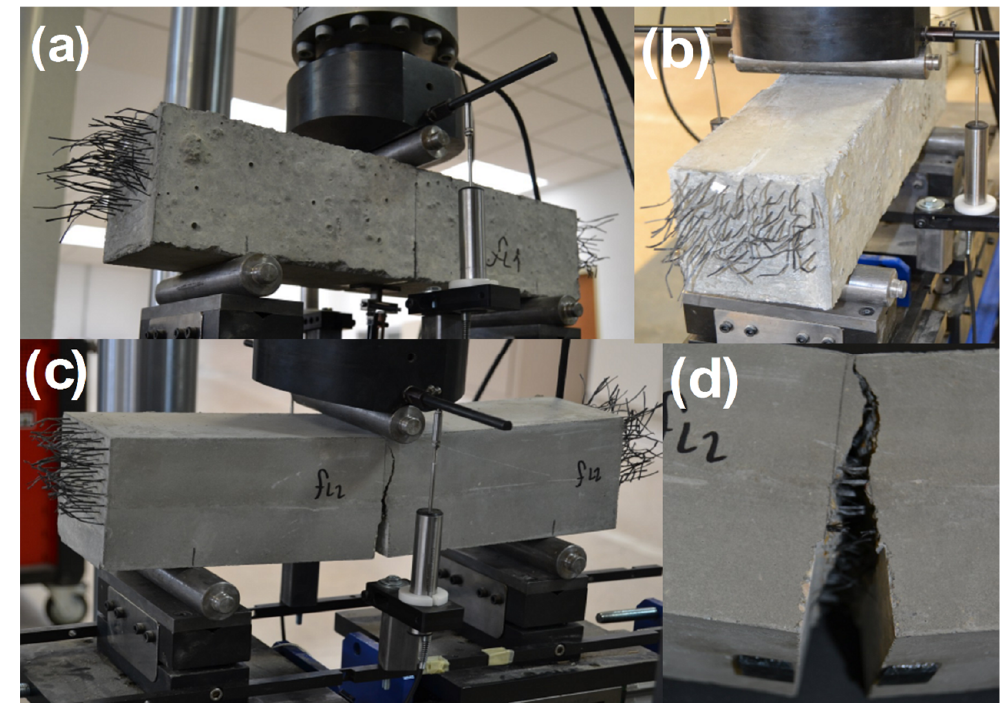
Figure 5. ( a ) Specimen ready for the test; ( b ) test disposition in the testing machine; ( c ) crack fully developed while testing; ( d ) image of the fracture surface generated in the fracture test with the fibers bridging the crack sides.